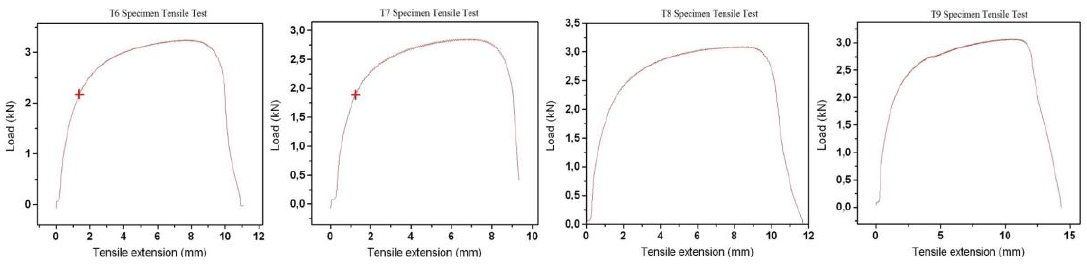
Figure 7. Force–extension curves of the successful results.